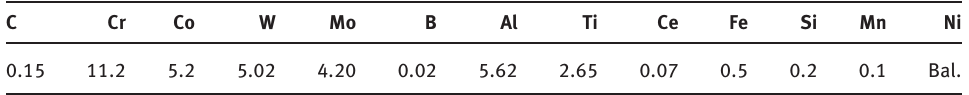
Table 1: The chemical composition of K403 nickel-based superalloy (mass %).